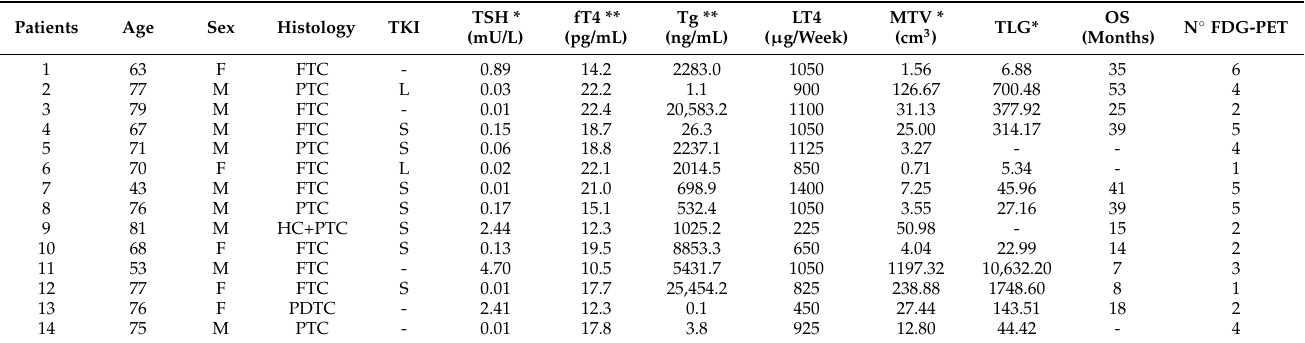
Table 1. Study population; clinical characteristics at baseline 2-[ 18 F]FDGPET